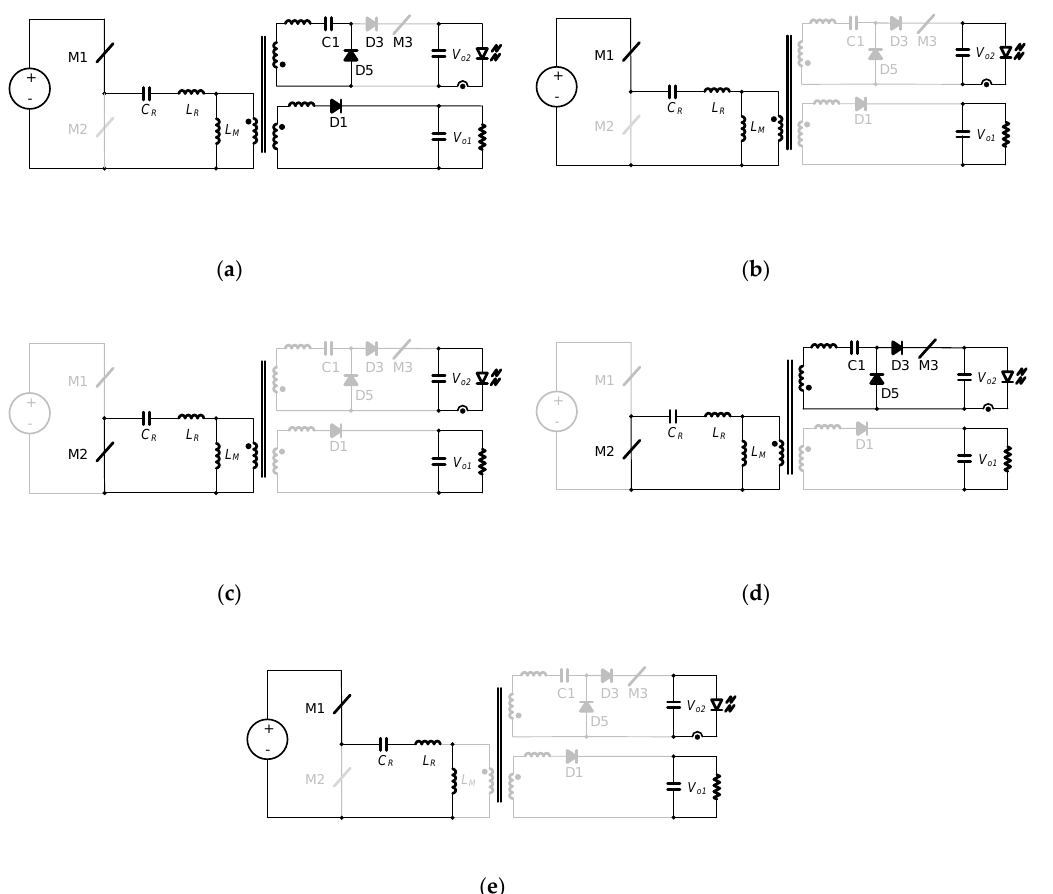
Figure 5. Operation modes of the proposed converter: ( a ) Mode 1; ( b ) Mode 2; ( c ) Mode 3; ( d ) Mode 4; and ( e ) Mode 5.